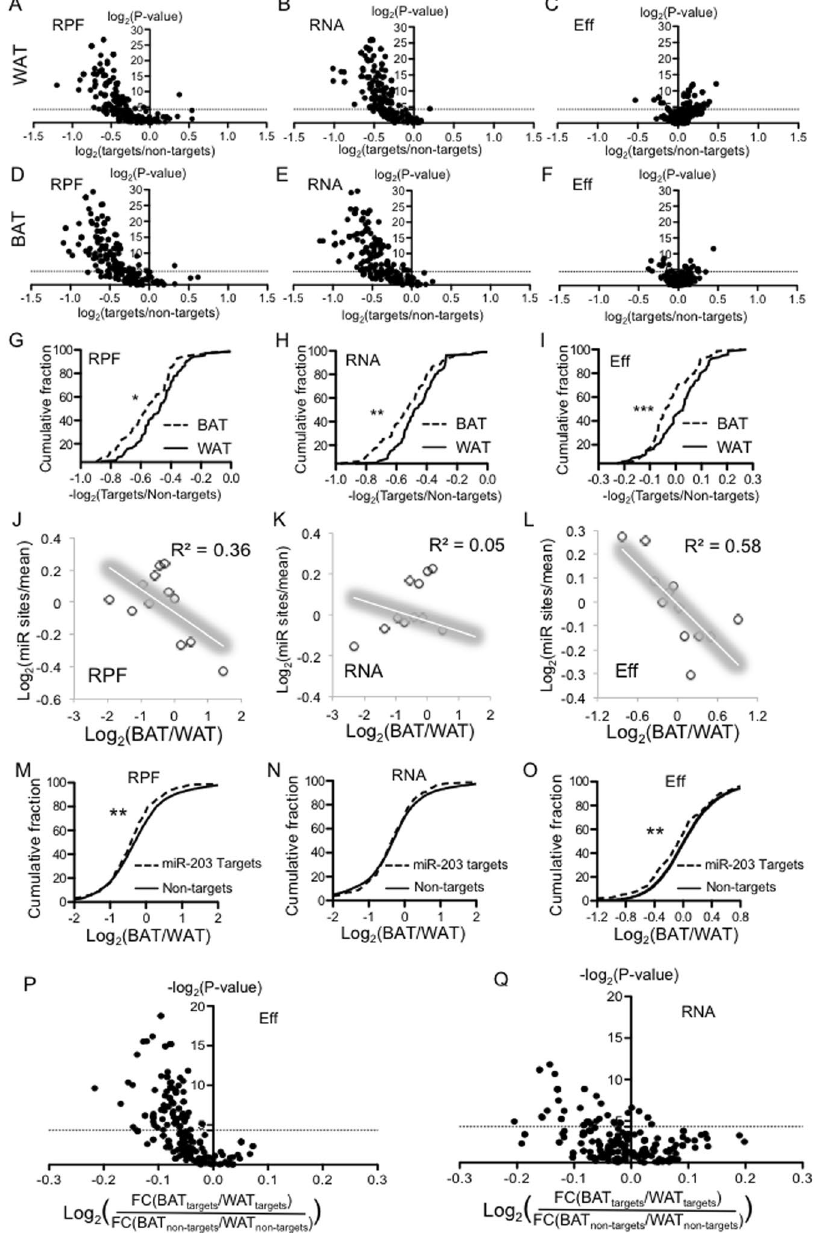
Figure 4. microRNAs contribute to the differential translation between BAT and WAT. ( A – C ) For each microRNA, P values for the cumulative distribution of its target vs. non-targets expression were calculated by KS test. An example is illustrated in Fig. 4SA–C. The P values were plotted (y-axis) againt the FCs of targets’ mean value vs. non- targets’ mean value (x-axis). ( A ) Based on RPF; ( B ) Based on RNA expression; ( C ) based on translational efficiency. ( A – C ) Were derived from WAT data. ( D – F ) Similar to A–C, but were decrived from BAT data. ( G – I ) Comparision of the target repression in BAT vs WAT at ( G ) RPF, ( H ) RNA and ( I ) Eff level. For microRNAs whose targets are signficantly repressed in WAT or BAT in term of total translational output (RPF), the ratio of targets’ mean value vs non-targets’ mean value were calculated. The culmulative curves of these ratios (target/non-target) in BAT and WAT were plotted. ( J – L ) MicroRNA binding sites distribution in mRNAs binned according to their expression ratios between BAT and WAT. ( J ) Based on RPF ( K ) based on RNA and ( L ) based on Eff. Data points were fit into a linear model. ( M – O ) The FCs in BAT vs WAT for each mRNA was calcuated. ( M ) Was based on RFP, ( N ) based on RNA, ( O ) based on Eff. The culmulative curves for miR-203 targets’ FCs and non-targets’ FCs were plotted. KS test was used to calculated P value. ( P , Q ) As decribed in M, the KS test P values for the differential distribution between targets vs. non-targets were calculated for each microRNA. The P values were plotted as y-axis. For each microRNA, the FCs of targets (or non-targets) between BAT and WAT were calculated. The ratios between FC of targets and FC of non-targets were plotted as the value in x-axis. ( P ) is based on Eff and ( Q ) is based on RNA. * Represents P value < 0.05; ** represents P value < 0.01; *** represents P value < 0.001 (Kolmogorov–Smirnov